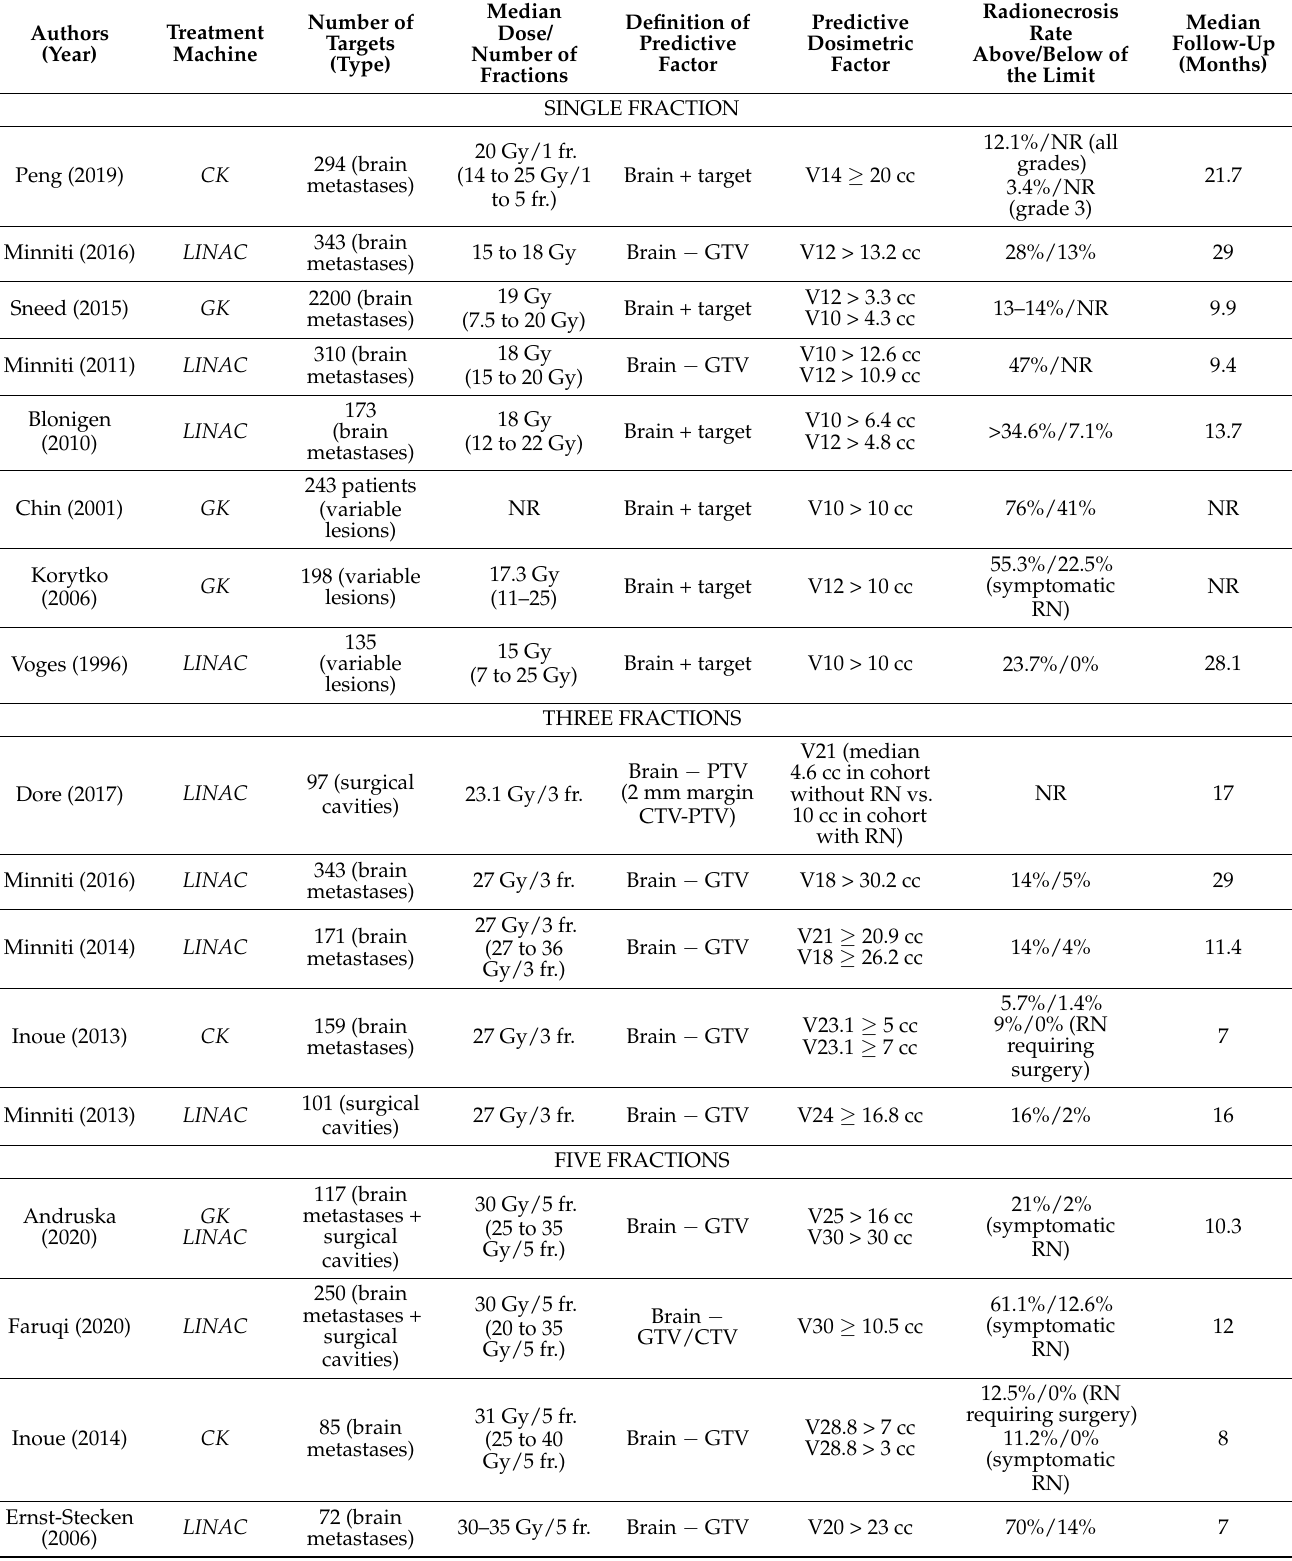
Table 2. Studies on brain metastases SRT reporting the normal brain volume as predictive factor of